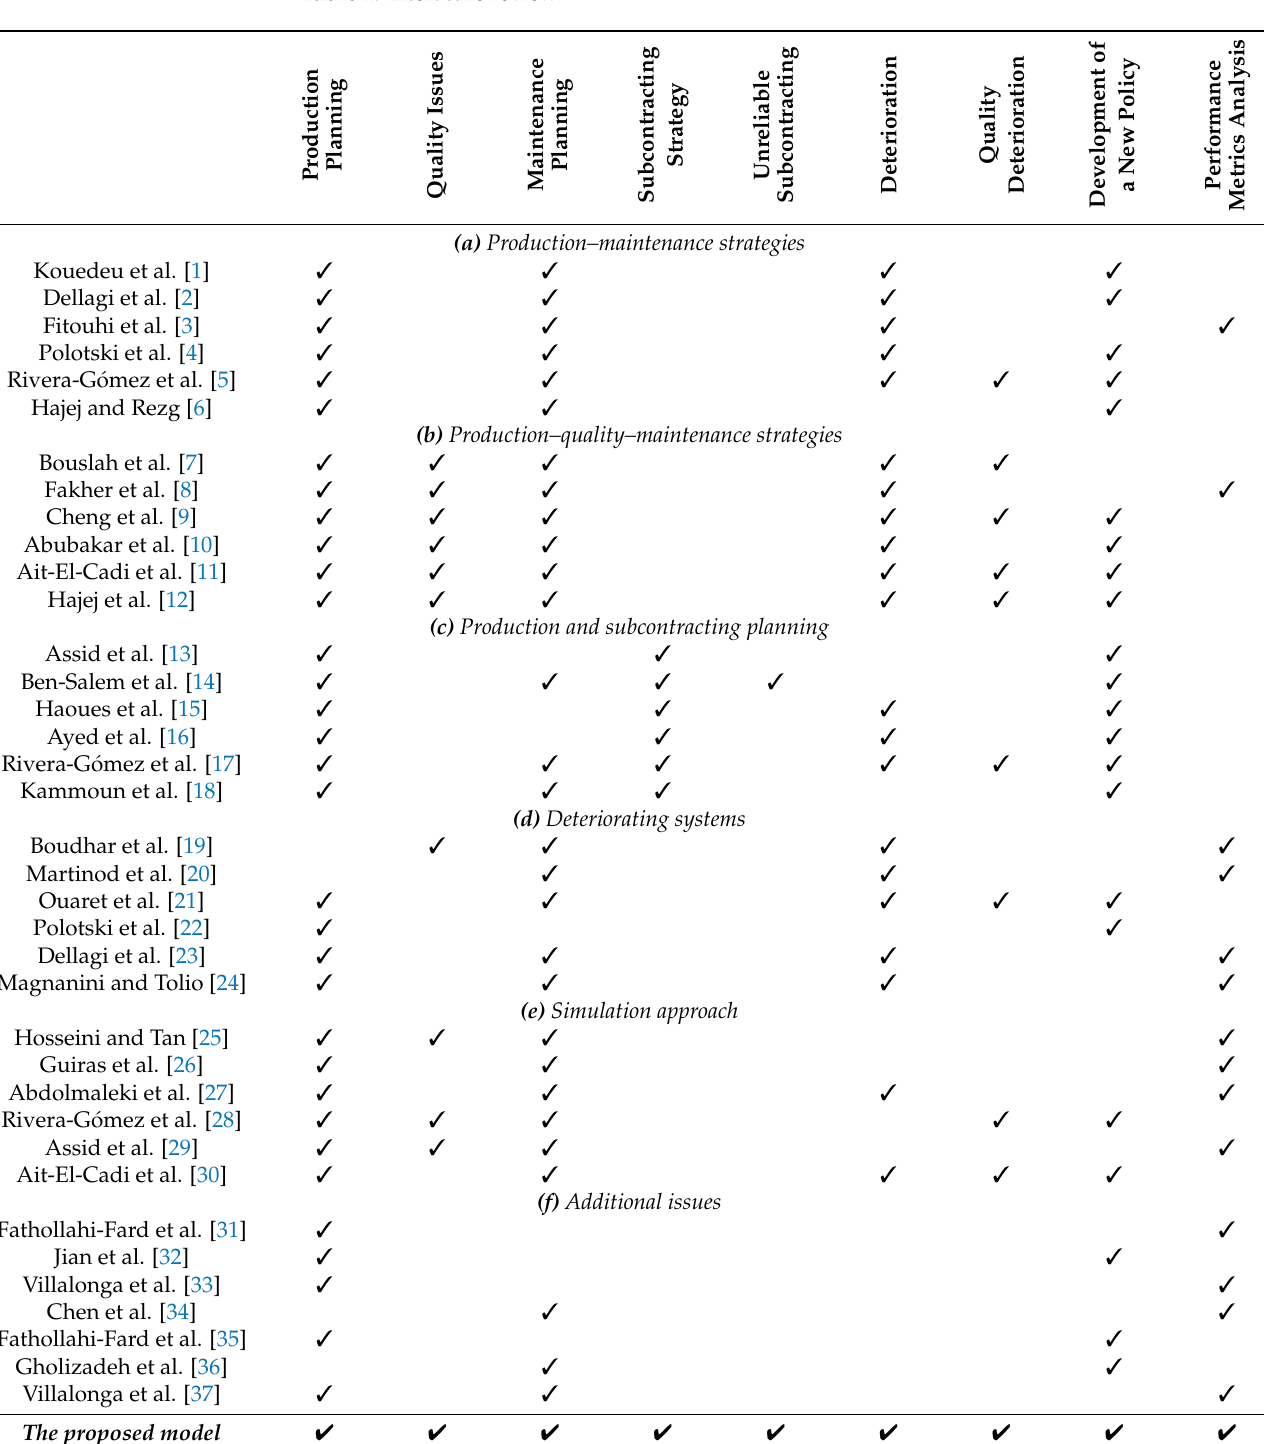
Table 1. Literature